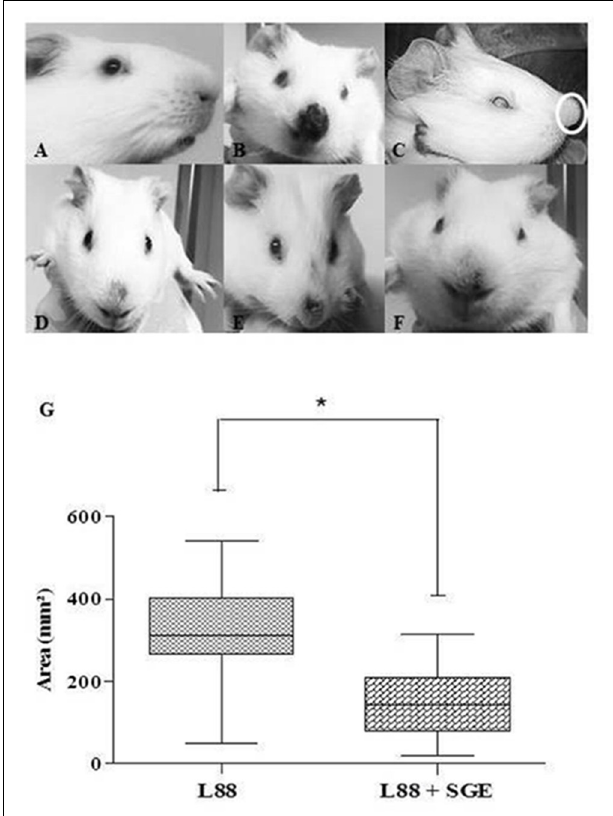
FIGURE 1 | Nasal region of C. porcellus infected with L. enriettii (L88 and Cobaia) strains in the presence/absence of salivary gland extract (SGE). (A) Uninfected C. porcellus (negative control). Macroscopical evalution at 6 (B–E) and 10 weeks (F) PI. (B) L88-infected C. porcellus . (C) Cobaia-infected C. porcellus showing a nasal protuberance (nodular lesion – white circle). (D–F) Lesion progression towards healing (F) in L88-infected C. porcellus in the presence of SGE showing alopecia and hyperemia (D,E) . (G) Impact of SGE in the lesion size (mm 2 ) of L88-infected C. porcellus throughout the experiment ( ∗ indicates statistical difference, p <